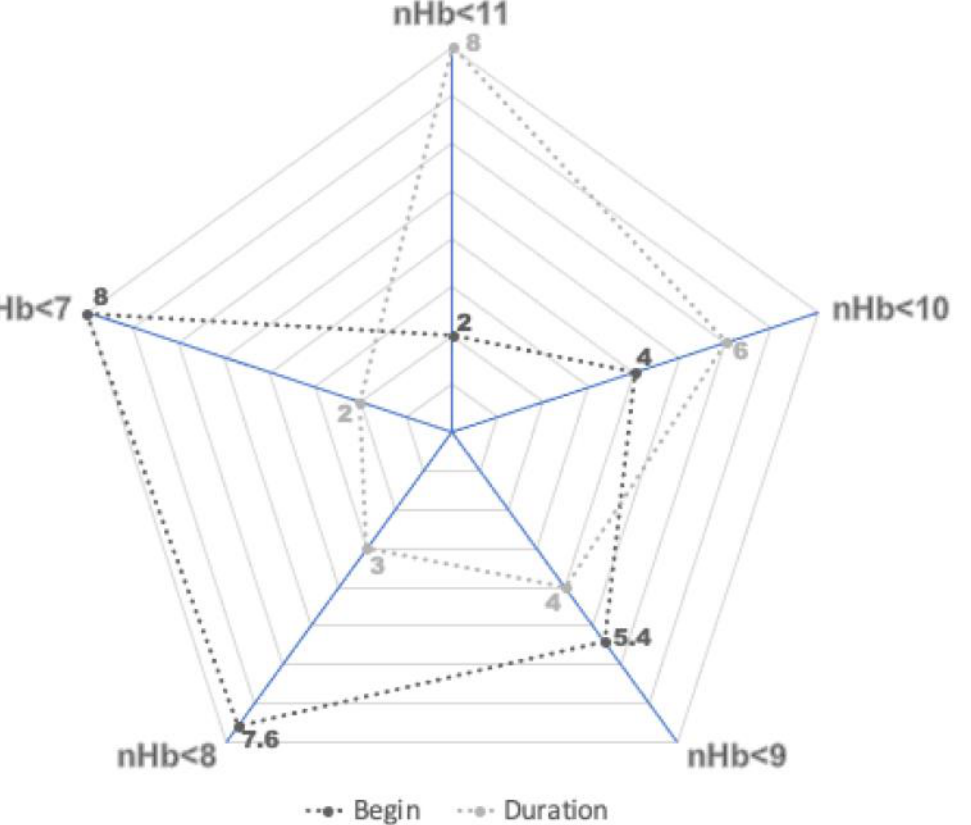
Figure 2. Onset and duration of anemia in days for each subgroup of anemia. For every g/dL drop in nadir hemoglobin (nHb) level, a later onset during the SAH was observed. The duration of the anemia was inversely related to its severity.